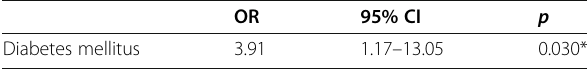
Table 2 Clinical characteristics of the hemodialysis patients with